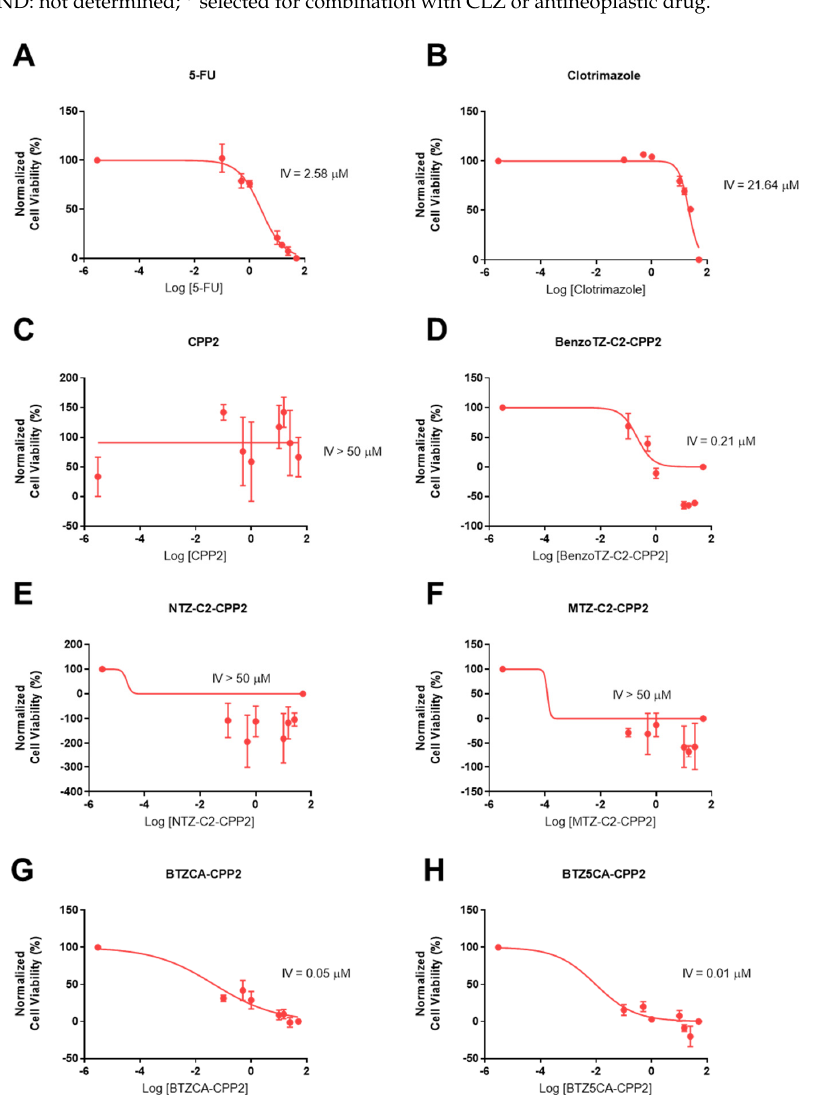
Figure 3. Concentration–response curves of 5-FU ( A ), CLZ ( B ), CPP2 ( C ), BenzoTZ-C2-CPP2 ( D ), NTZ-C2-CPP2 ( E ), MTZ-C2-CPP2 ( F ), BTZCA-CPP2 ( G ) and BTZ5CA-CPP2 ( H ) on HT-29 cells based on the results obtained by MTT assay. The results represent the mean ± SEM of three inde- pendent experiments performed in triplicate.